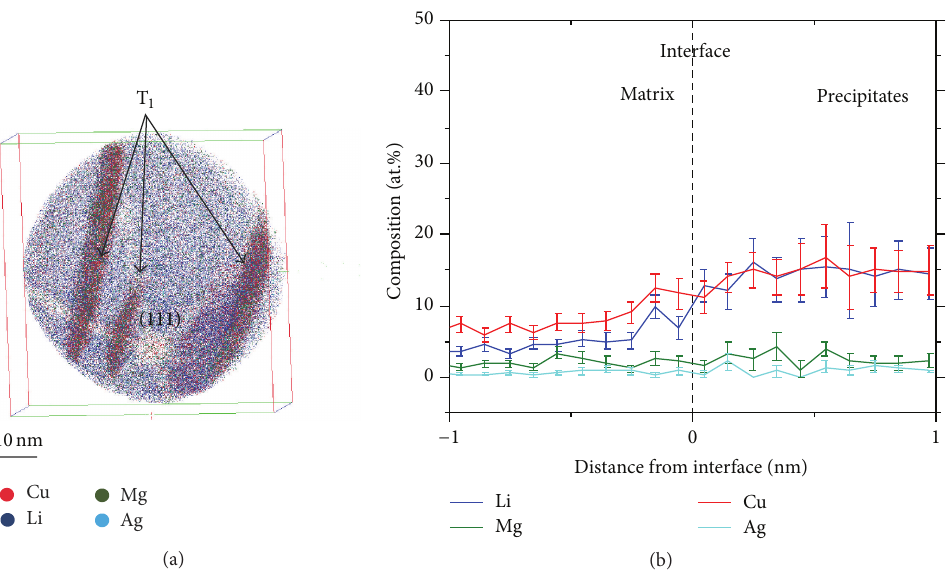
Figure 6: LEAP analysis at 22 K and 18% of pulse fraction. (a) Top view of the reconstructed volume of a sample shows the intersections of the T 1 platelets with the (111) pole. (b) Corresponding combined proxigram composition profile for T 1 with the chemical composition of ( 14.3 ± 2 ) at.% Cu, ( 15.5 ± 3 ) at.% Li, ( 2.5 ± 1 ) at.% Mg, and ( 0.8 ± 0.5 ) at.%